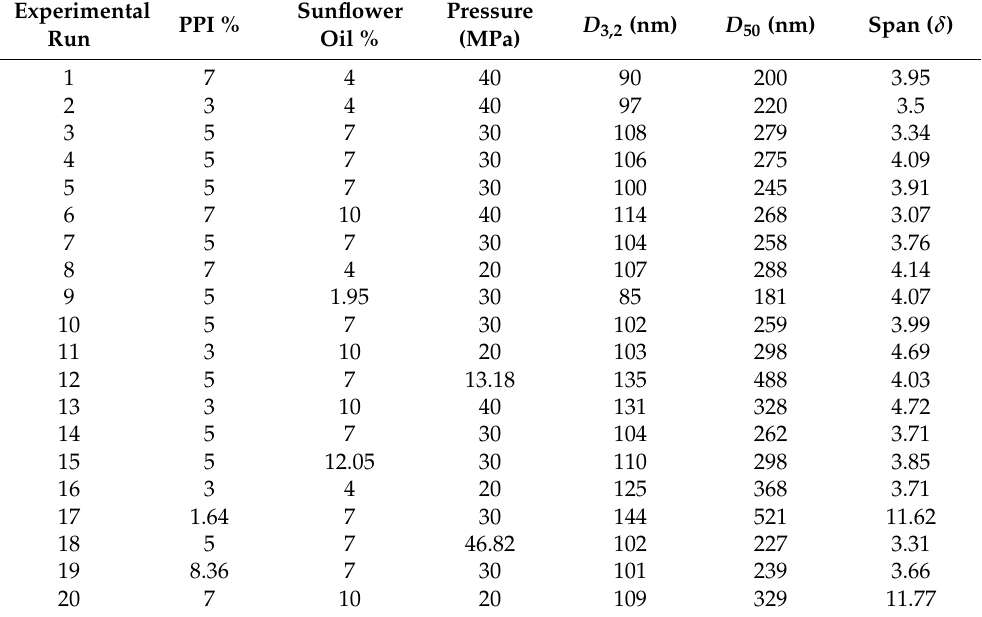
Table 1. Central composite rotatable design (CCRD) for the preparation of pea protein isolate (PPI)- stabilized sunflower oil in water nanoemulsions via high-pressure homogenization and the mean values for the responses viz. Sauter mean diameter ( D 3,2 ), median droplet diameter ( D 50 ), and span ( δ